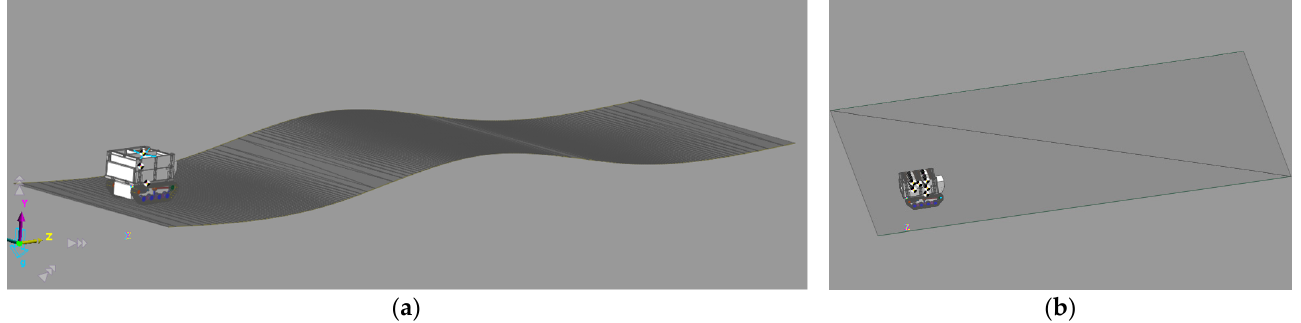
Figure 6. ( a ) The design model of ± 8 degree up and downslope surface and ( b ) horizontal ground surface